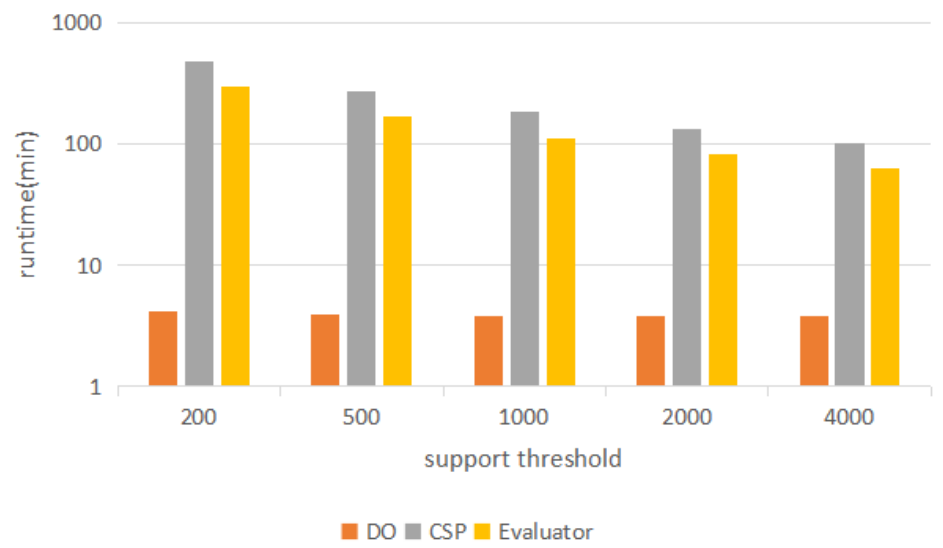
Figure 5. Computational costs of DO, CSP, and Evaluator.